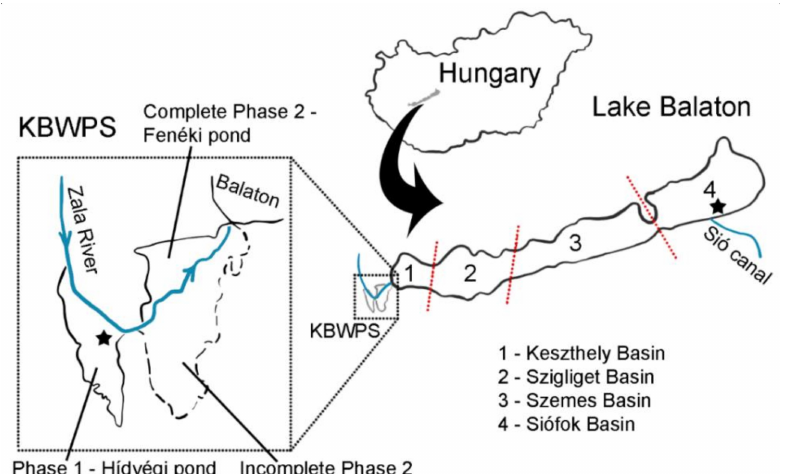
Figure 1. Map of Hungary and graphical depictions of the Kis-Balaton Water Protection System (KBWPS) and Lake Balaton. Sampling sites are labeled with an asterisk. Figure is based on those in Kov á cs et al. [2] and Hatvani et al. [16] with permission from the